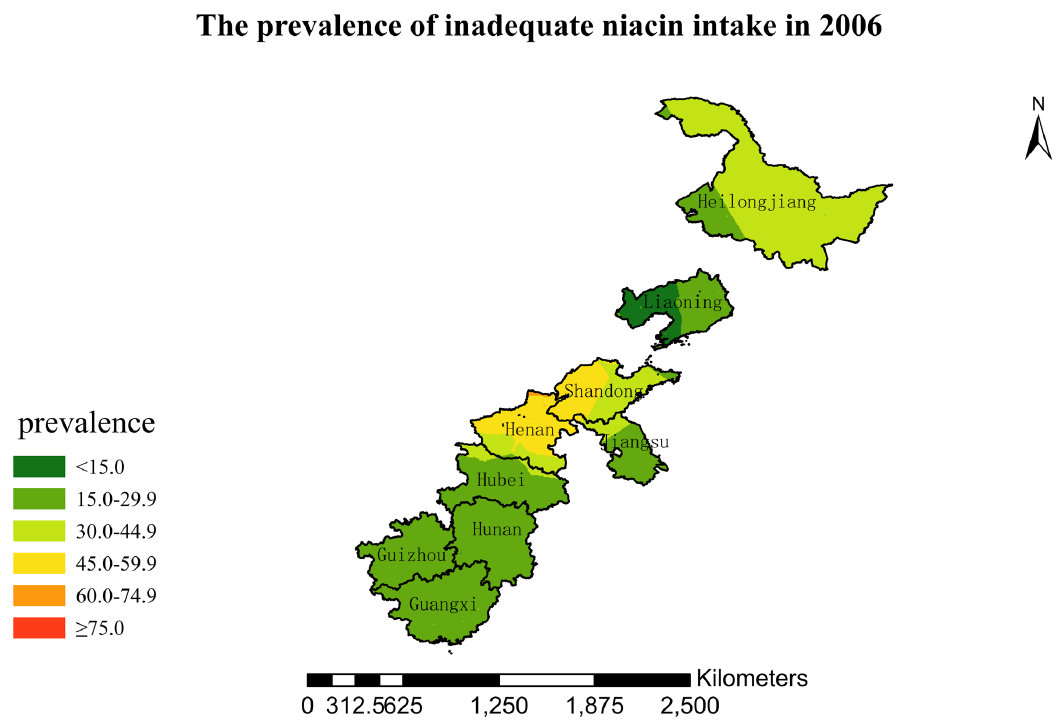
Figure 6. The prevalence of inadequate niacin intake by county in 2006 among Chinese Residents ≥ 5 Years of Age.